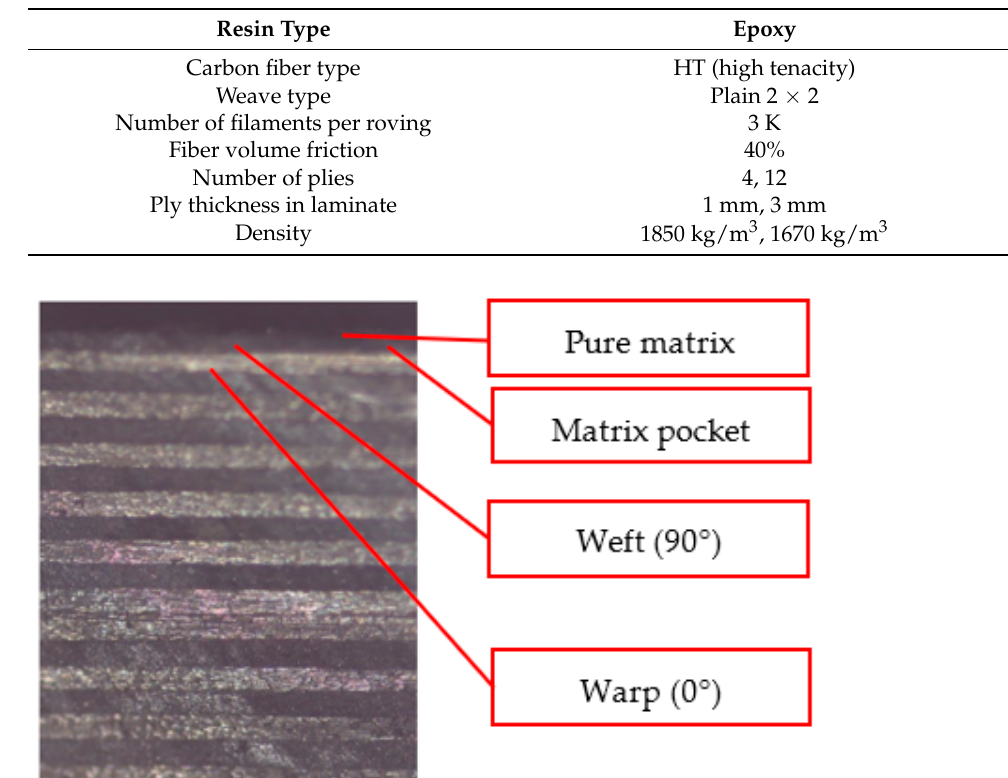
Table 1. Material characteristics of the examined CFRP laminate.